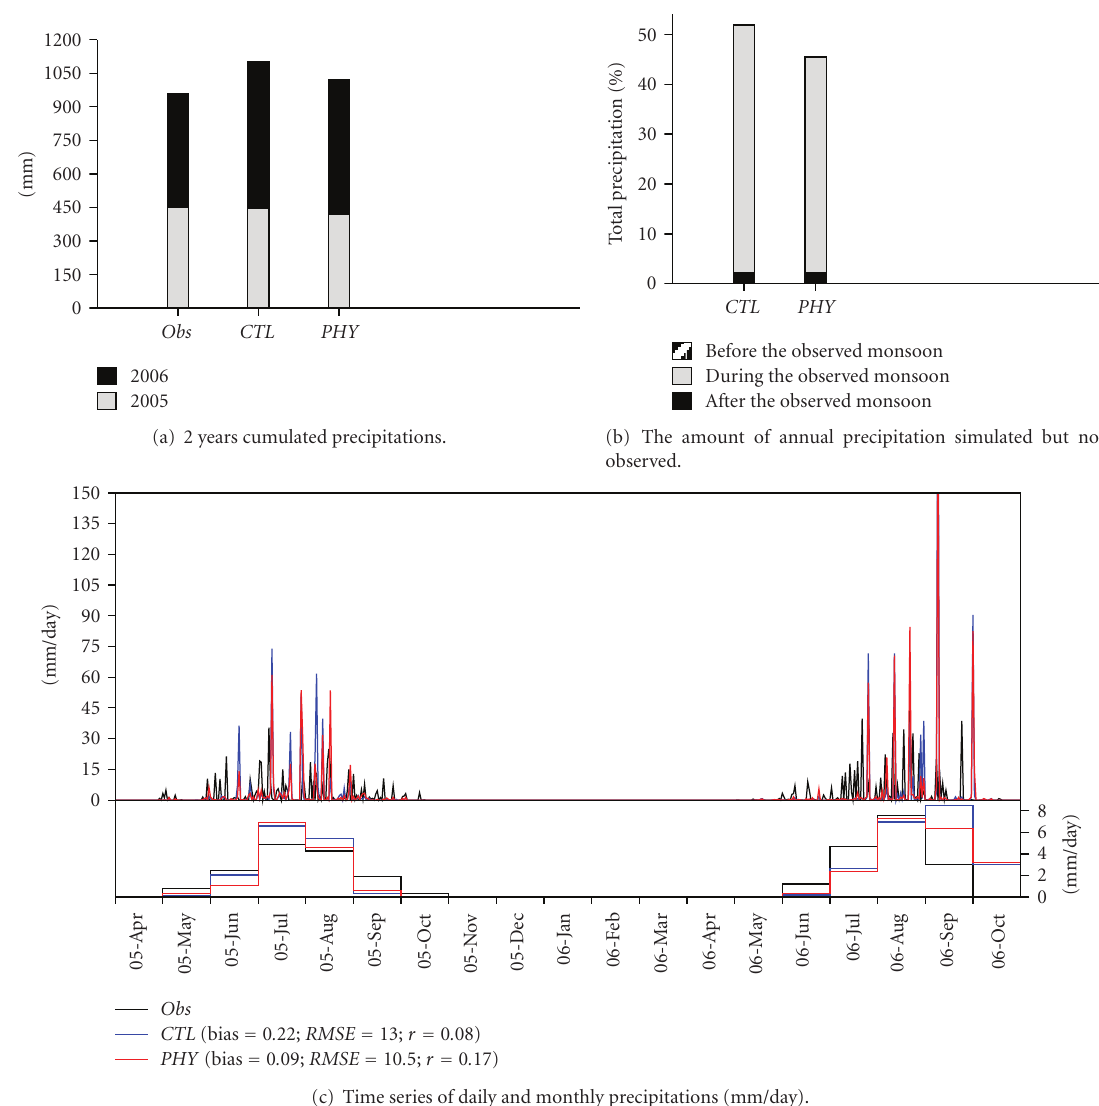
Figure 2: Domain average comparison between simulated and observed precipitation over Dantiandou Kori: (a) the cumulated annual precipitation rate (mm) simulated by each experiment; (b) the ratio to annual precipitation of daily precipitation simulated by each experiment but not observed, expressed in %, distinctions are made for precipitations that are simulated before, during and after the observed monsoon season; (c) the times series of simulated and observed monthly and daily precipitations (mm/day). The observations are in black, CTL in blue and PHY in red. The daily biases, the root mean square errors ( RMSE ) and the correlations ( r ) are also given for each